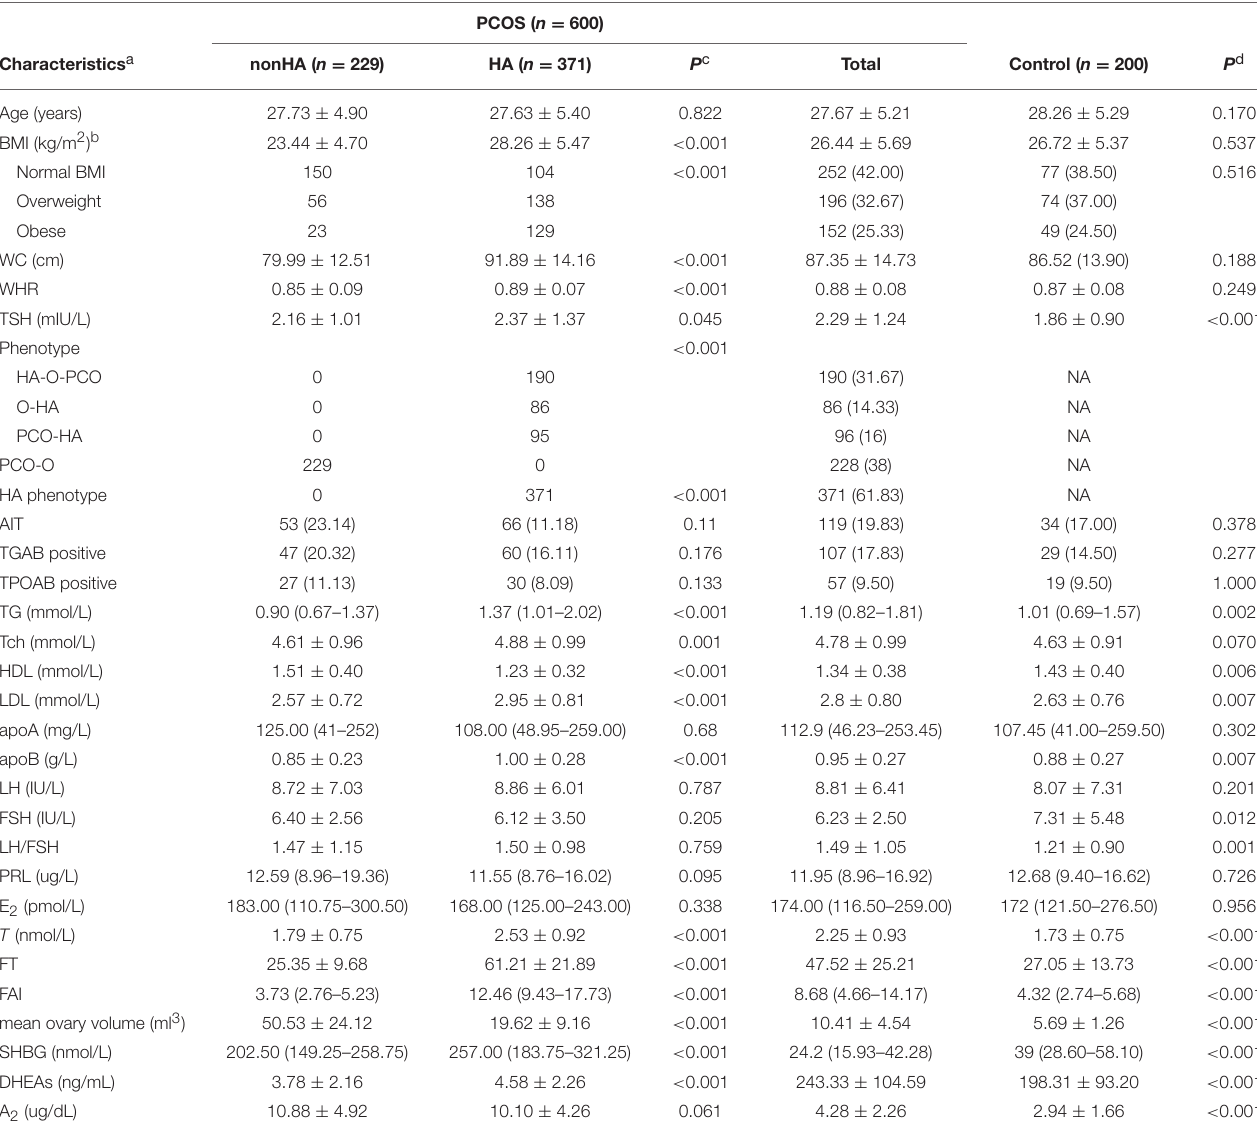
TABLE 1 | Clinical and biochemical characteristics in PCOS patients and controls.